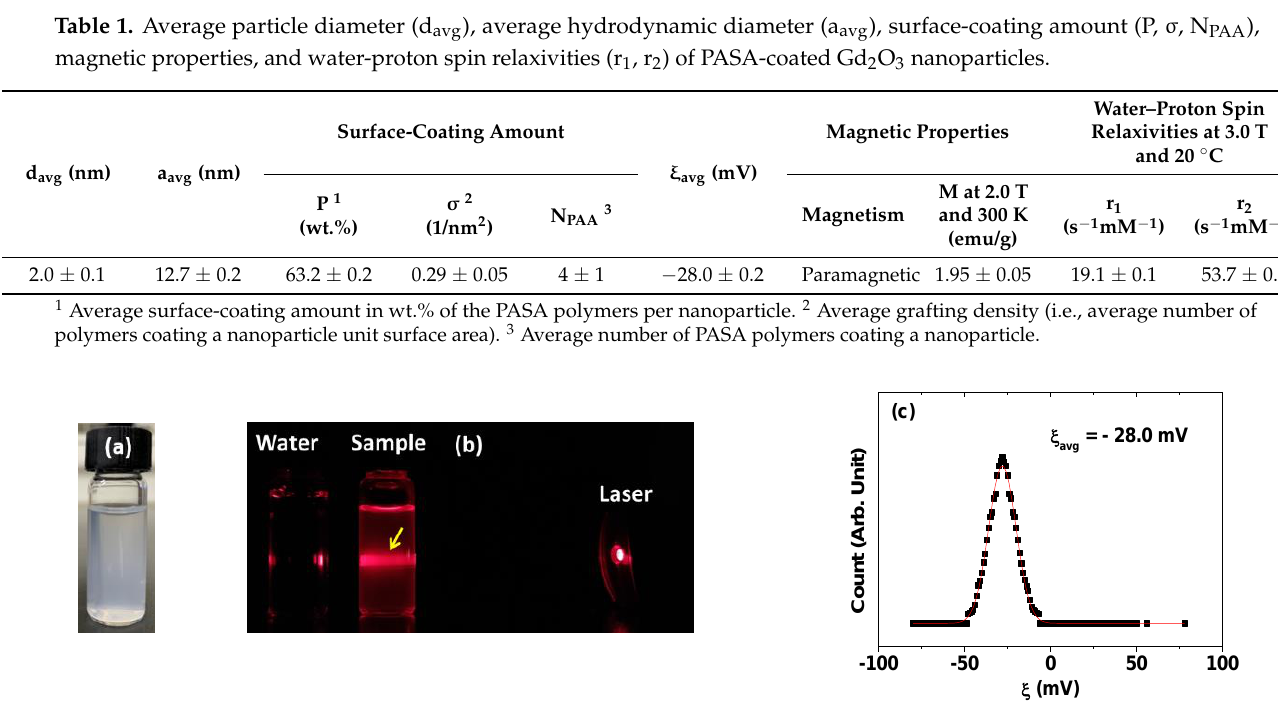
Table 1. Average particle diameter (d avg ), average hydrodynamic diameter (a avg ), surface-coating amount (P,  , N PAA ), magnetic properties, and water-proton spin relaxivities (r 1 , r 2 ) of PASA-coated Gd 2 O 3 nanoparticles.